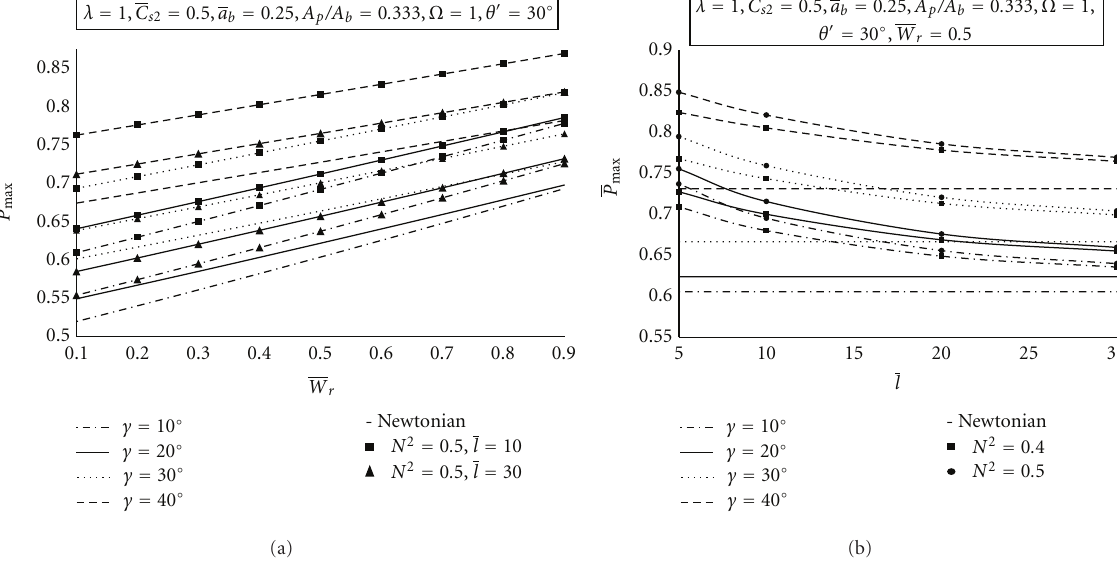
Figure 6: (a) Variation of maximum fluid film pressure ( P max ) versus radial load ( W r ). (b) Variation of maximum fluid film pressure ( P max ) versus characteristic length ( l